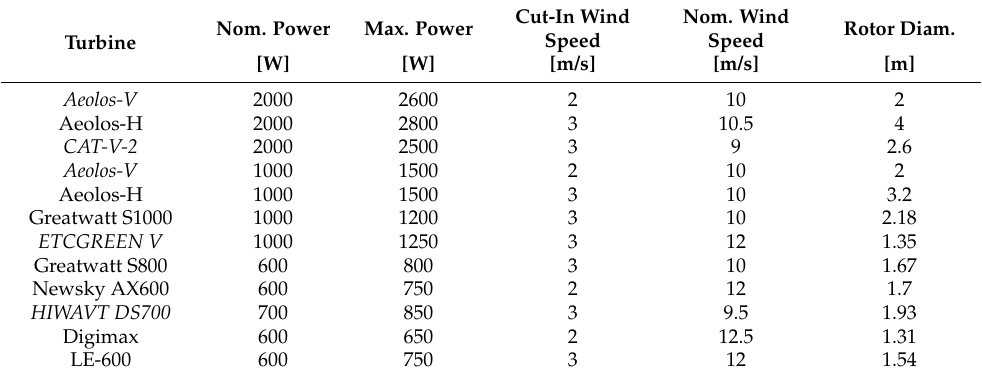
Table 3. Turbine